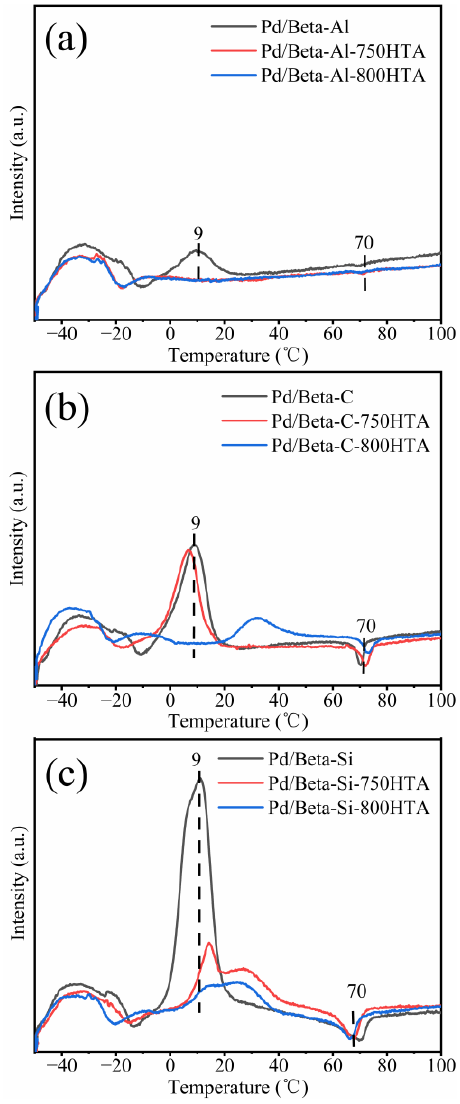
Figure 6. H 2 -TPR profiles of ( a ) Pd/Beta-Al, Pd/Beta-Al-750HTA and Pd/Beta-Al-800HTA; ( b ) Pd/Beta-C, Pd/Beta-C-750HTA and Pd/Beta-C-800HTA; ( c ) Pd/Beta-Si, Pd/Beta-Si-750HTA andPd/Beta-Si-800HTA.